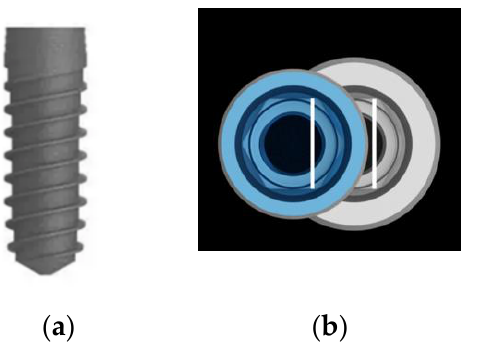
Figure 1. ( a ) Klockner VEGA Surface ContacTi ® implant; ( b ) 4.0 and 4.5 mm diameter platform with an internal hexagon connection change of 0.35 and 0.60 mm, respectively.